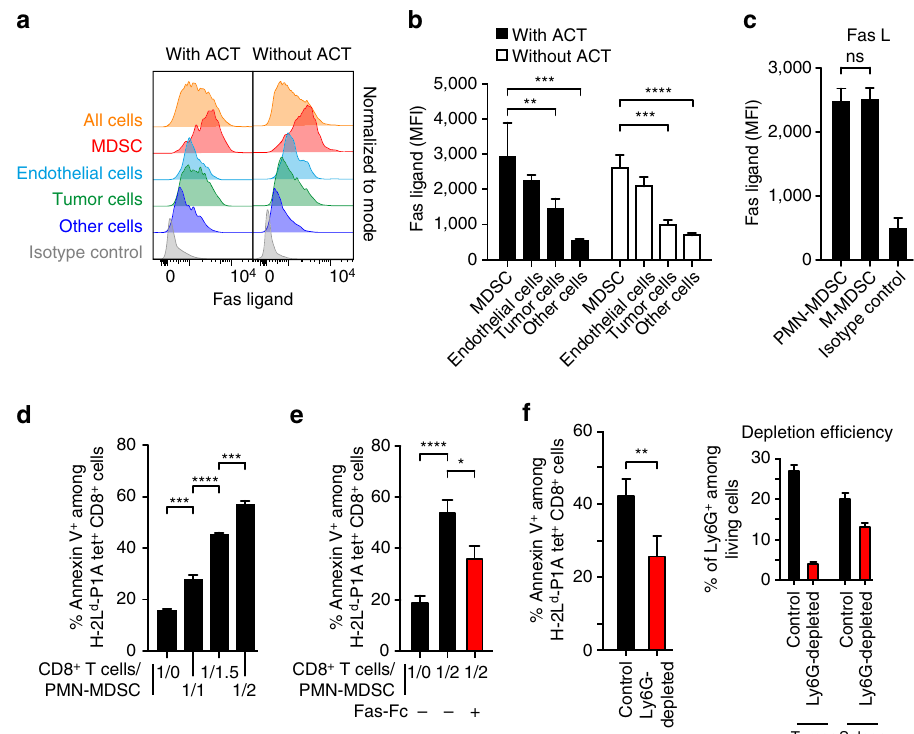
Fig. 7 PMN-MDSC induce CD8 + T-cell apoptosis through Fas-ligand. a FasL expression was analyzed by FACS on cell homogenates from two representative induced Amela TiRP tumors, having received ACT or not 4 days earlier. Top panel : whole cell population. Second panel : MDSC (Gr1 + CD11b + ). Third panel : Endothelial cells (CD31 + ). Fourth panel : Tumor cells (P1A + , CD45 - ). Fifth panel : Other cells (Gr1 − , CD11b − , CD31 − , P1A − ). Sixth panel : isotype control. b Mean fl uorescence intensity (MFI) of FasL expression of indicated cells obtained as in Fig. 6a (induced tumor with ACT: n = 12; induced tumor without ACT: n = 12). c Comparison of mean fl uorescence intensity (MFI) of FasL expression by M-MDSC and PMN-MDSC (induced tumors without ACT: n = 8). d Apoptosis of activated TCRP1A CD8 + T cells upon co-incubation for 24 h at the indicated ratio with PMN-MDSC isolated from induced Amela TiRP tumors. Purity of PMN-MDSC cells: 80 – 90%. Five independent experiments, each in duplicate. e Apoptosis of activated TCRP1A CD8 + T cells was prevented by adding soluble Fas-Fc (10 µ g/ml) to PMN-MDSC 1 h before and during the 24 h co-incubation with activated TCRP1A CD8 + T cells.